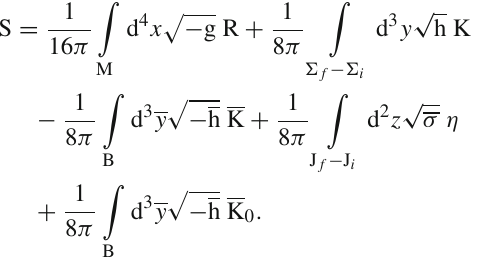
M, consists of the initial and final spacelike surfaces (cid:2) i , and (cid:2) f , see Fig. 1, as well as a timelike boundary B. For every (cid:2) t , we can define a two surface, B t (cid:2) t . The set of two surfaces B t , then foliates the boundary B. The intersections (cid:2) i ∩ B, and (cid:2) f ∩ B, are called the junctions and are denoted by J i , and J f ,